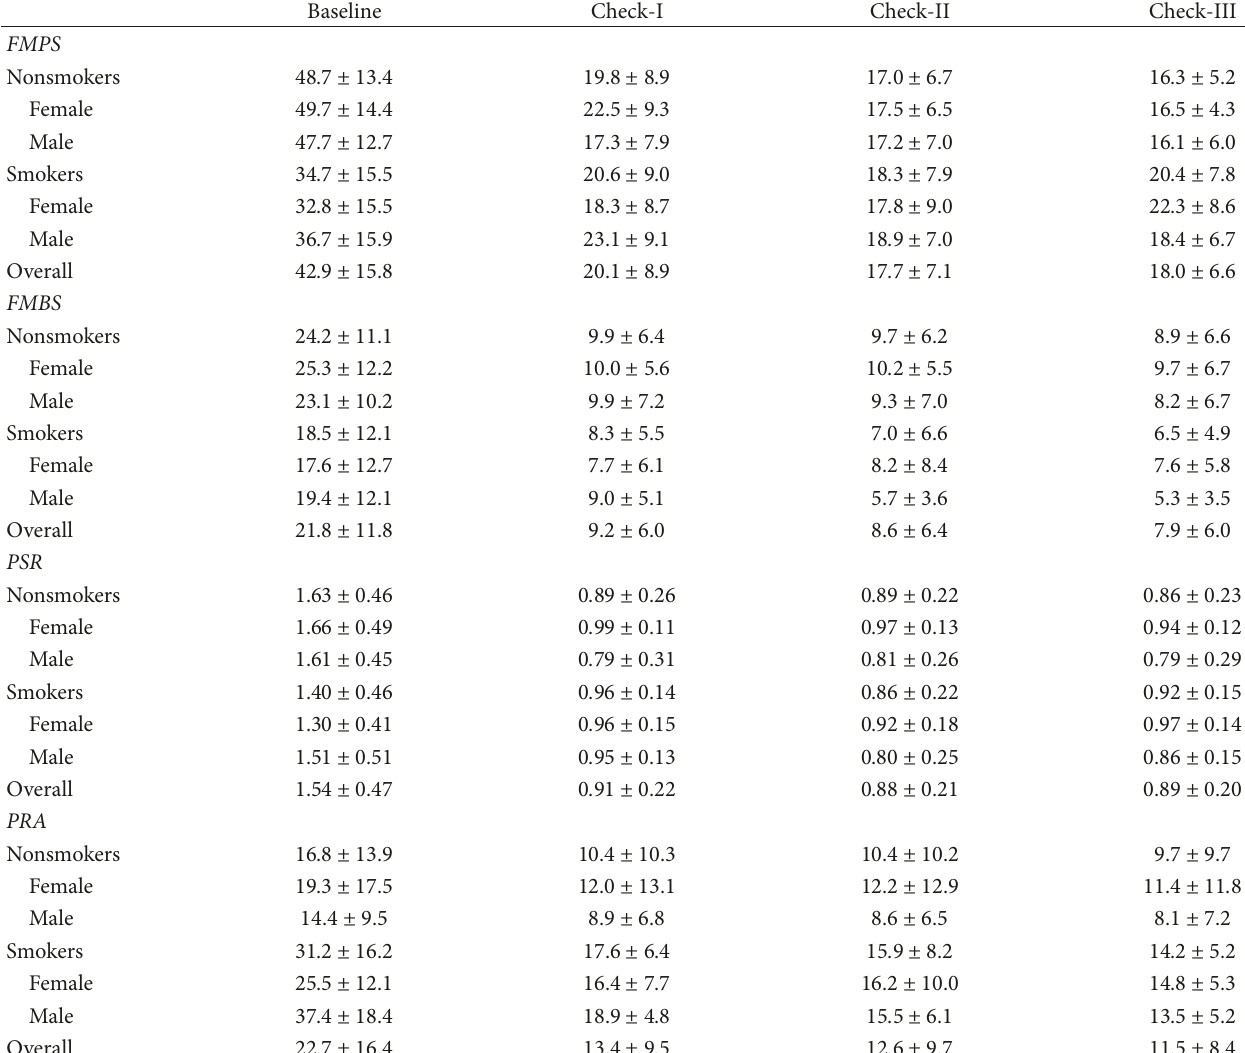
Table 2: Assessed periodontal indices, grouped by gender and smoker